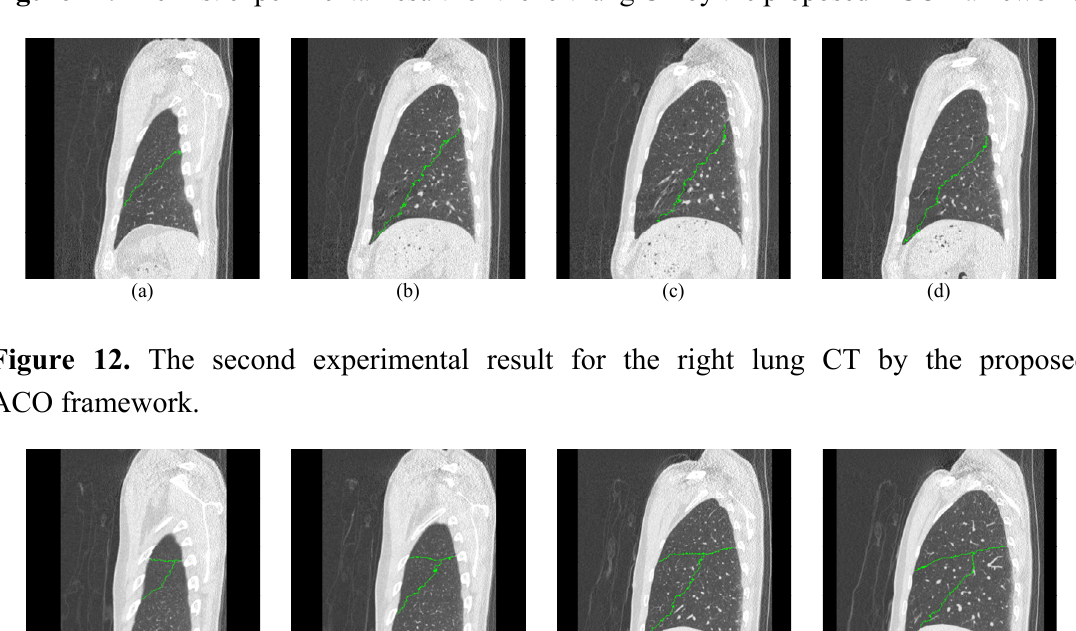
Figure 11. The first experimental result for the left lung CT by the proposed ACO framework.